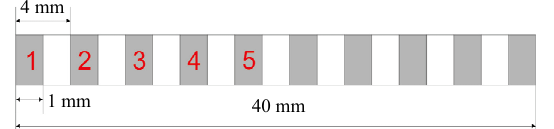
Fig. 5 Structural diagram of the SFG with parameters a = 1 mm, p = 4 mm, and L = 40 mm.